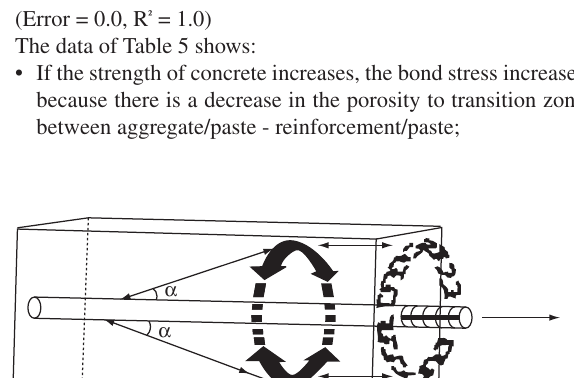
Steel bars: Table 3 and Table 4 show the characterization of reinforcing steel for all steel bar diameters. The relative rib area re- inforcing bars are prescribed in CEB 5,6,7 and EUROCODE 8 . If relative rib area reinforcing bars (ƒ = 0.056)) attain the minimum prescribed R value in the standardizations 5,8 , the steel bars are considered to be of high bond stress.